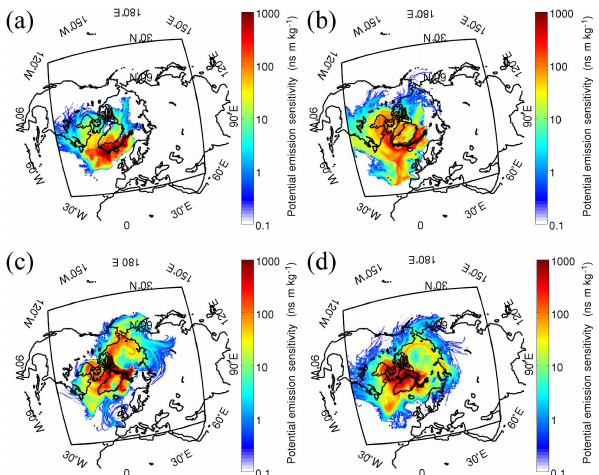
Figure 2. Simulated potential emission sensitivity (nsmkg − 1 ) from FLEXPART-WRF on 11, 12, 14, and 15 August 2012. Black square shows the WRF domain used to initiate the FLEXPART-WRF sim- ulation.